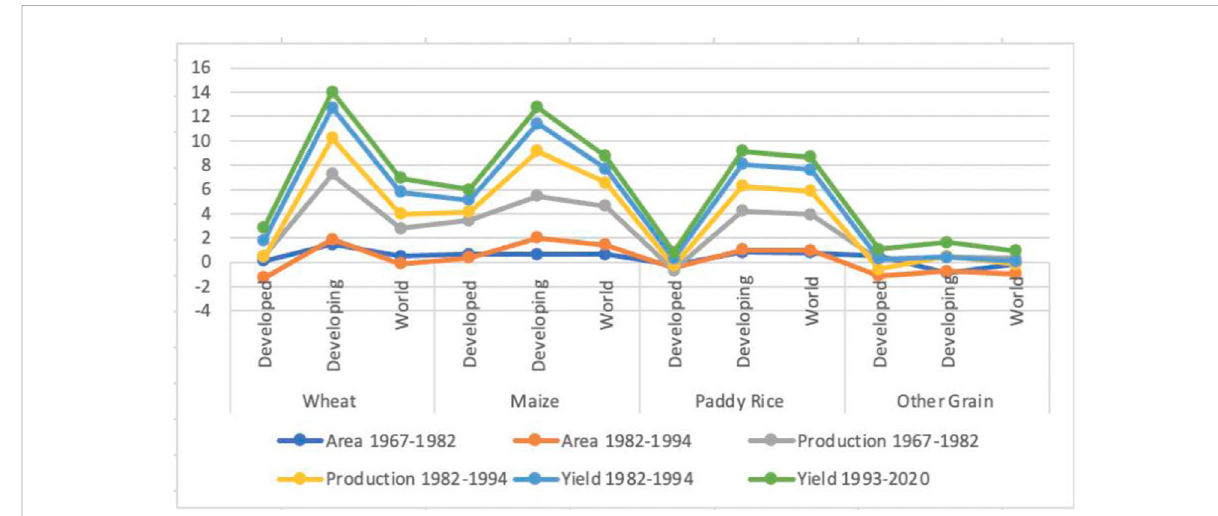
FIGURE 1 Agriculture productions. Sources: http://www.fao.org/3/x9447e07.htm#Notep.